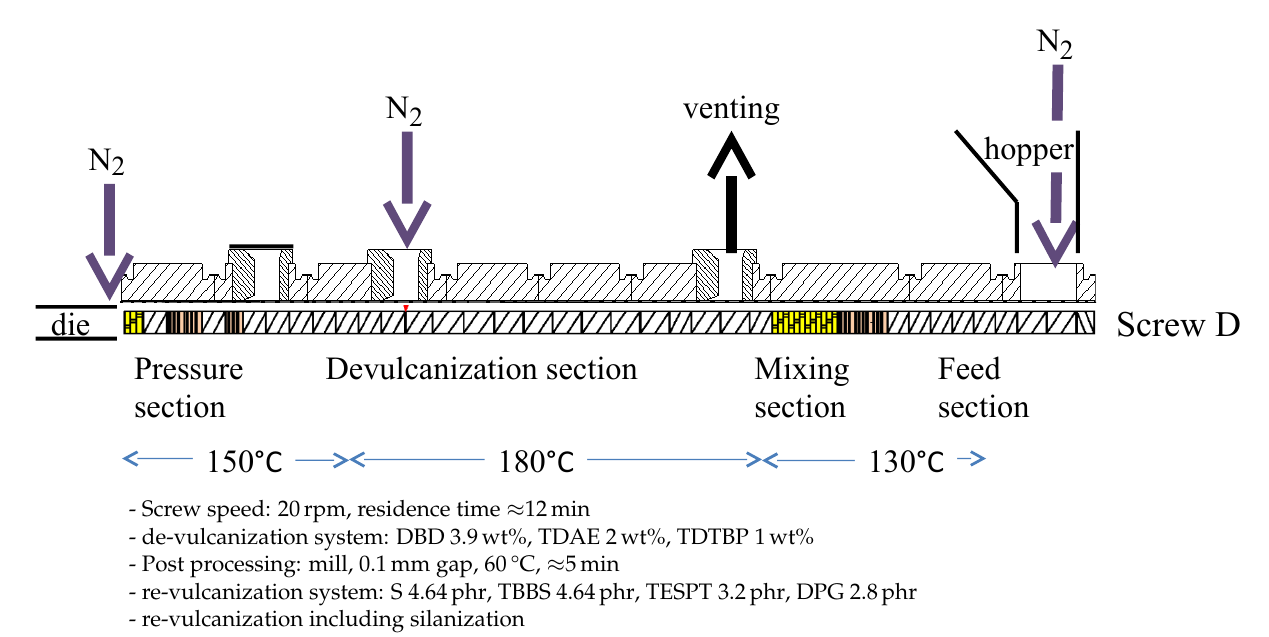
Figure 12. Extruder configuration and de-vulcanization process parameters for best tensile strength of